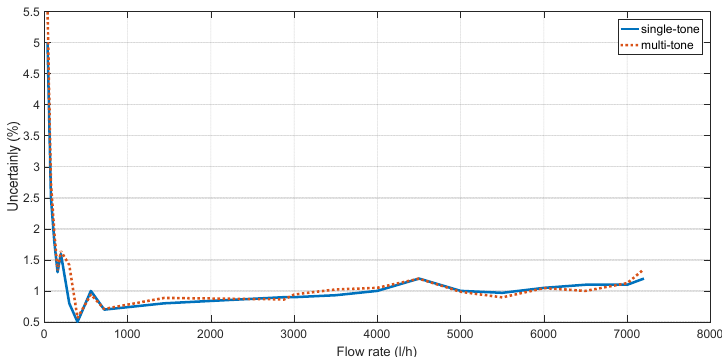
Figure 19. Uncertainty achieved for single-tone and multi-tone modes.